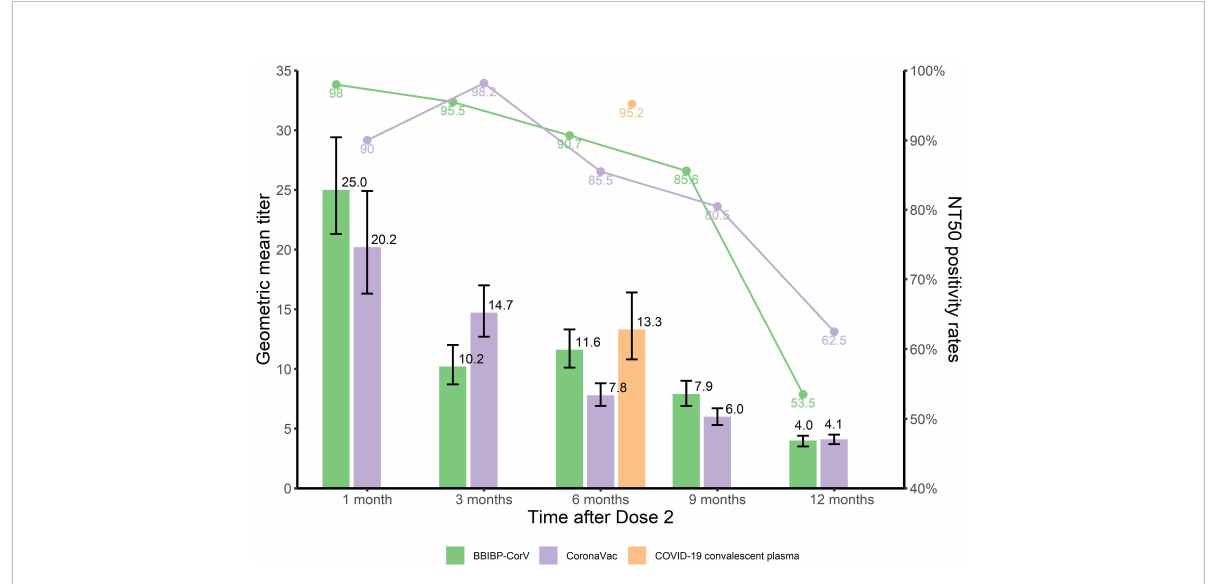
FIGURE 2 NT 50 positivity rates and GMTs of nAb at different time points after immunization with inactivated COVID-19 vaccine and COVID-19 convalescent sera.